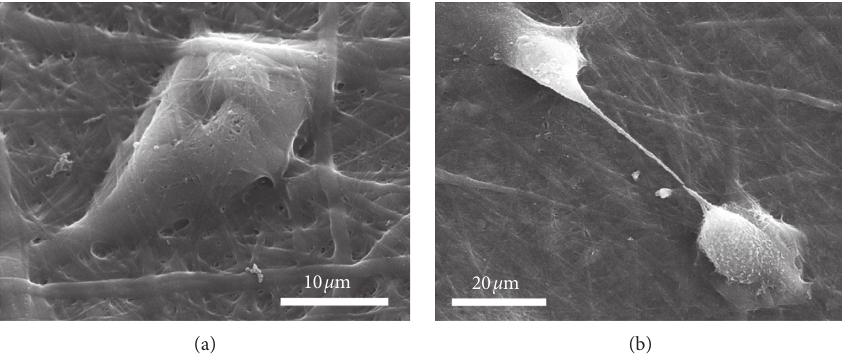
Figure 4: Scanning electron microscope images of human adipose tissue-derived mesenchymal stem cells (hAT-MSCs) cultured on cross- linked collagen electrospun nanofibers for 10 days.